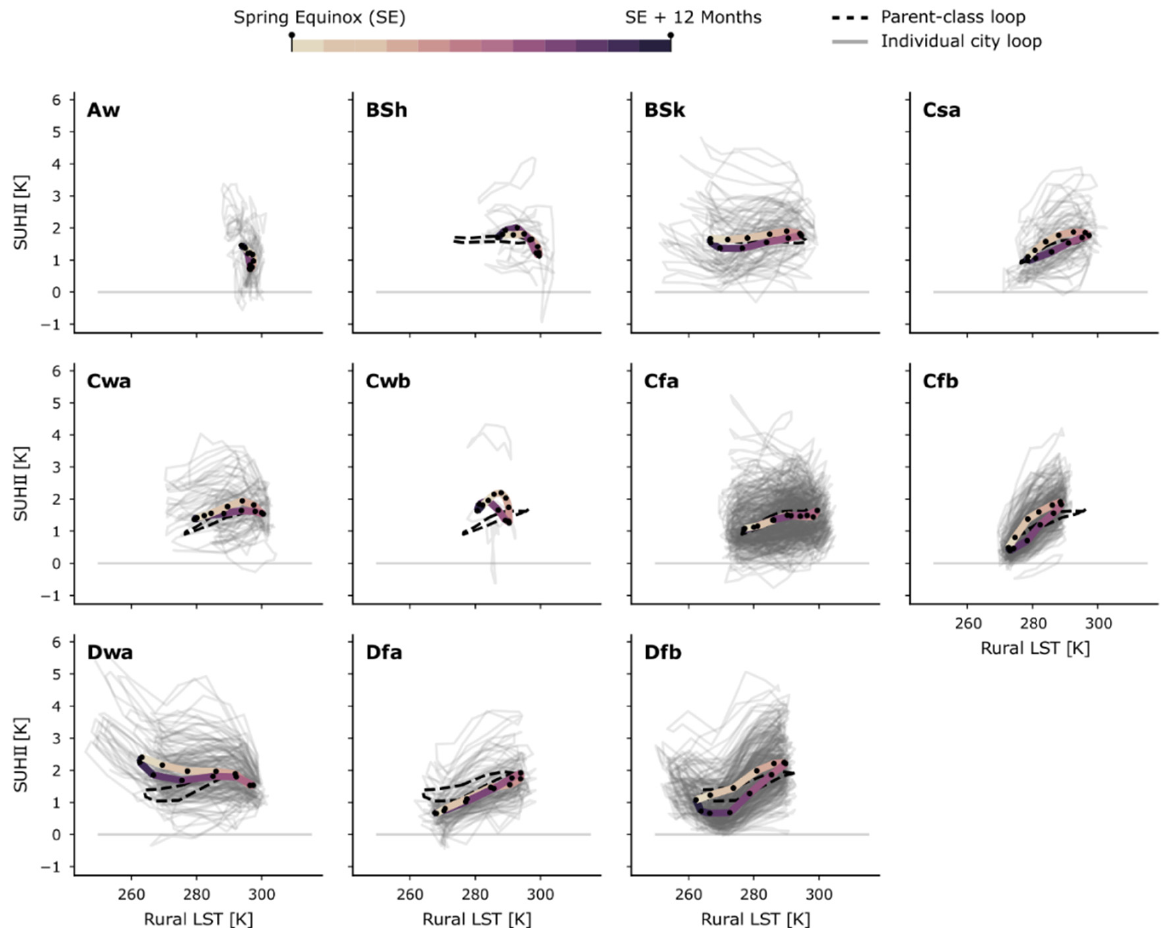
Figure 6. The nighttime SUHII hysteresis loops for each Köppen–Geiger climate class (colored lines). Each black dot represents a month (the start and end points correspond to spring equinox), and the change in color indicates the direction of each loop. The solid grey loops represent the individual city loops of each climate class, and the dashed one represents the corresponding parent-class loops.